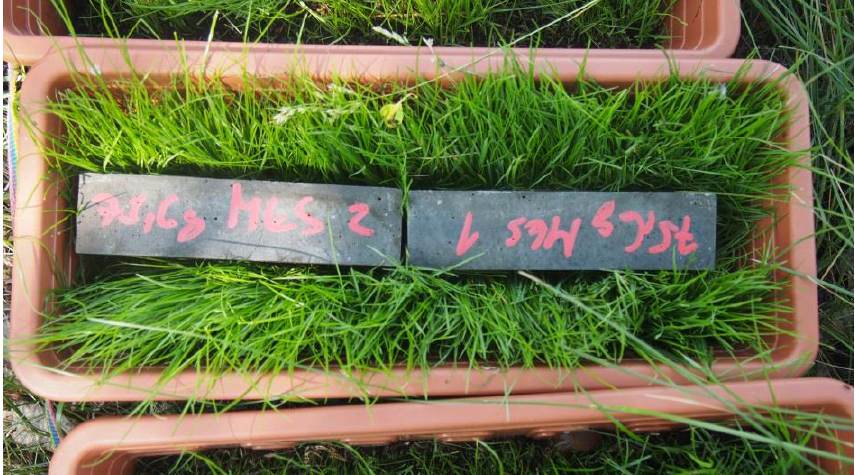
Figure 4. Placement of beams in grass boxes (B. Vojvodikova).